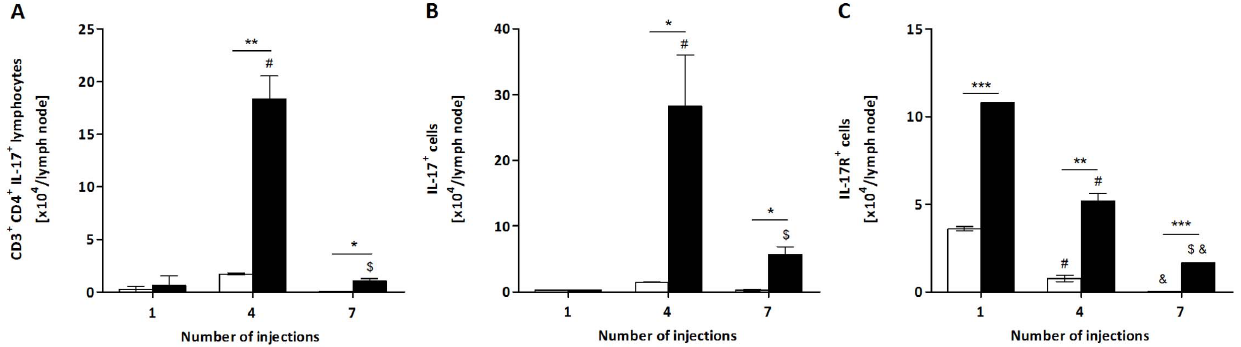
Figure 4. Total number of CD3 + CD4 + IL-17 + T lymphocytes, IL-17 + cells and IL-17R + cells from P . semirufa group. BALB/c mice were repeatedly injected with 50 m L of pyrogen-free saline ( % ) or 10 m g (protein) of the extract ( & ) in the footpad and, after the 1 st , 4 th and 7 th inoculations, the popliteal lymph nodes were collected and processed for flow cytometry analysis. Total number of (A) CD3 + CD4 + IL-17 + T lymphocytes, (B) IL-17 + cells and (C) IL-17R + cells. All graphs show mean values 6 SD. * p , 0.05 and *** p , 0.0001: significant differences between the mean values obtained with the saline group and the mean values of the P . semirufa group. The symbols indicate significant differences between the inoculations: 1 st 6 4 th ( # ), 1 st 6 7 th (&) and 4 th 6 7 th ( $